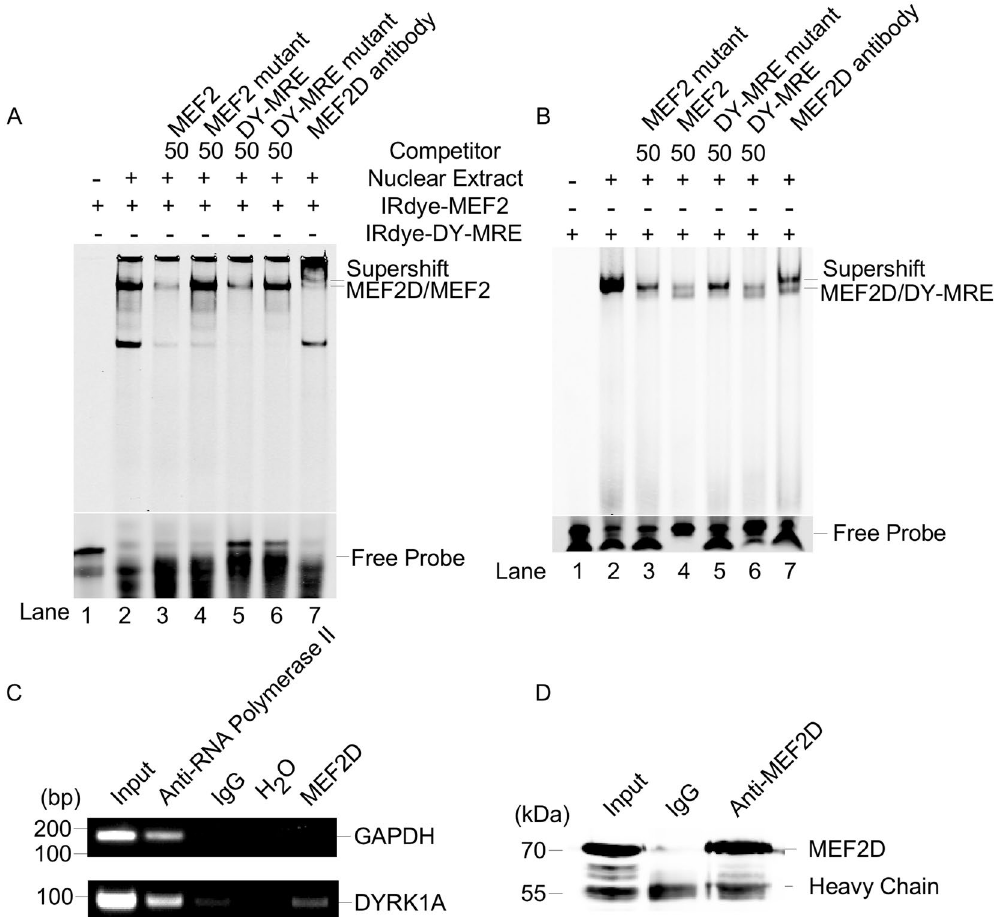
Figure 4. Confirmation of MRE on DYRK1A promoter by EMSA and ChIP. ( A ) The consensus MEF2 oligonucleotides were labelled with infrared fluorescence IRDye ® 700 and used as probes. EMSA was performed as described in methods. DY-MRE is the oligonucleotide of − 282 bp to − 251 bp from DYRK1A promoter. Numbers of competitor indicates the molar excess of labelled oligonucleotides. ( B ) DY-MRE was labelled with infrared fluorescence IRDye ® 700 IRDye. EMSA was performed as described in methods. Anti- MEF2D antibody was used in supershift. ( C ) ChIP was used to confirm the binding of MEF2D with DYRK1A promoter region. Anti-MEF2D antibody, anti-RNA Polymerase II and normal mouse IgG were used in chromatin immunoprecipitation from HEK293 cells. Primers to amplify a short DNA sequence spanning the putative DY-MRE site in DYRK1A promoter region and GAPDH were used for PCR. IgG and H 2 O were used as the negative controls. ( D ) Western blot showed that the anti-MEF2D antibody actually immunoprecipitated MEF2D protein. The lower bands were antibody heavy